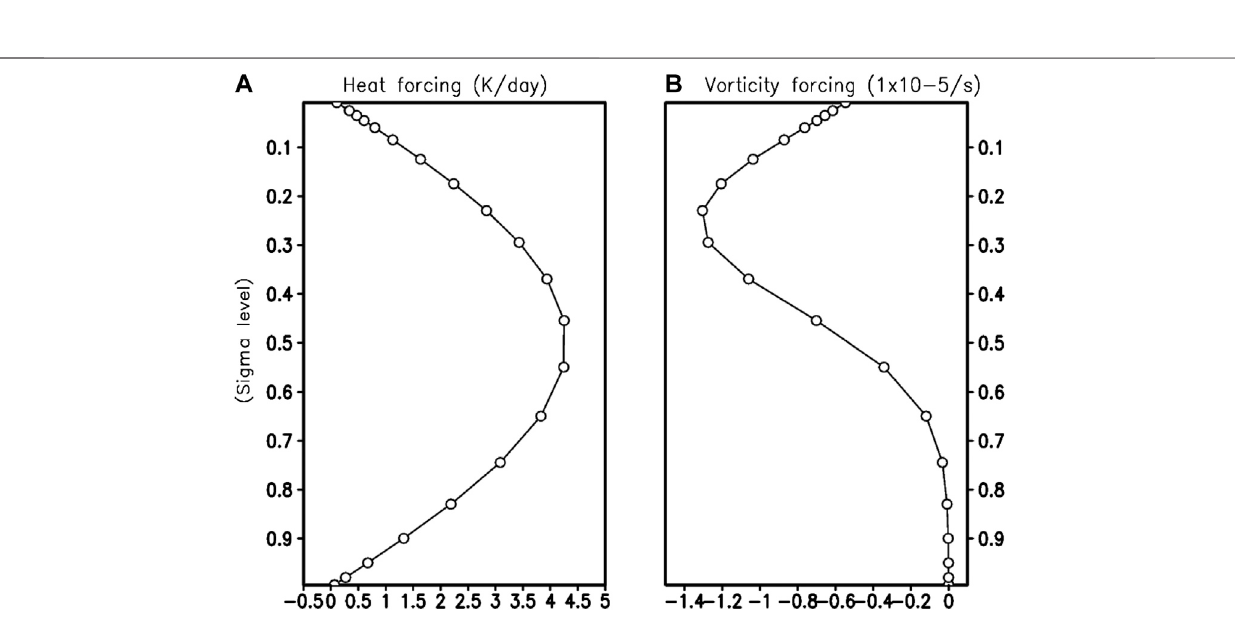
FIGURE 4 | Vertical pro fi les of individual heat and vorticity forcing for LBM